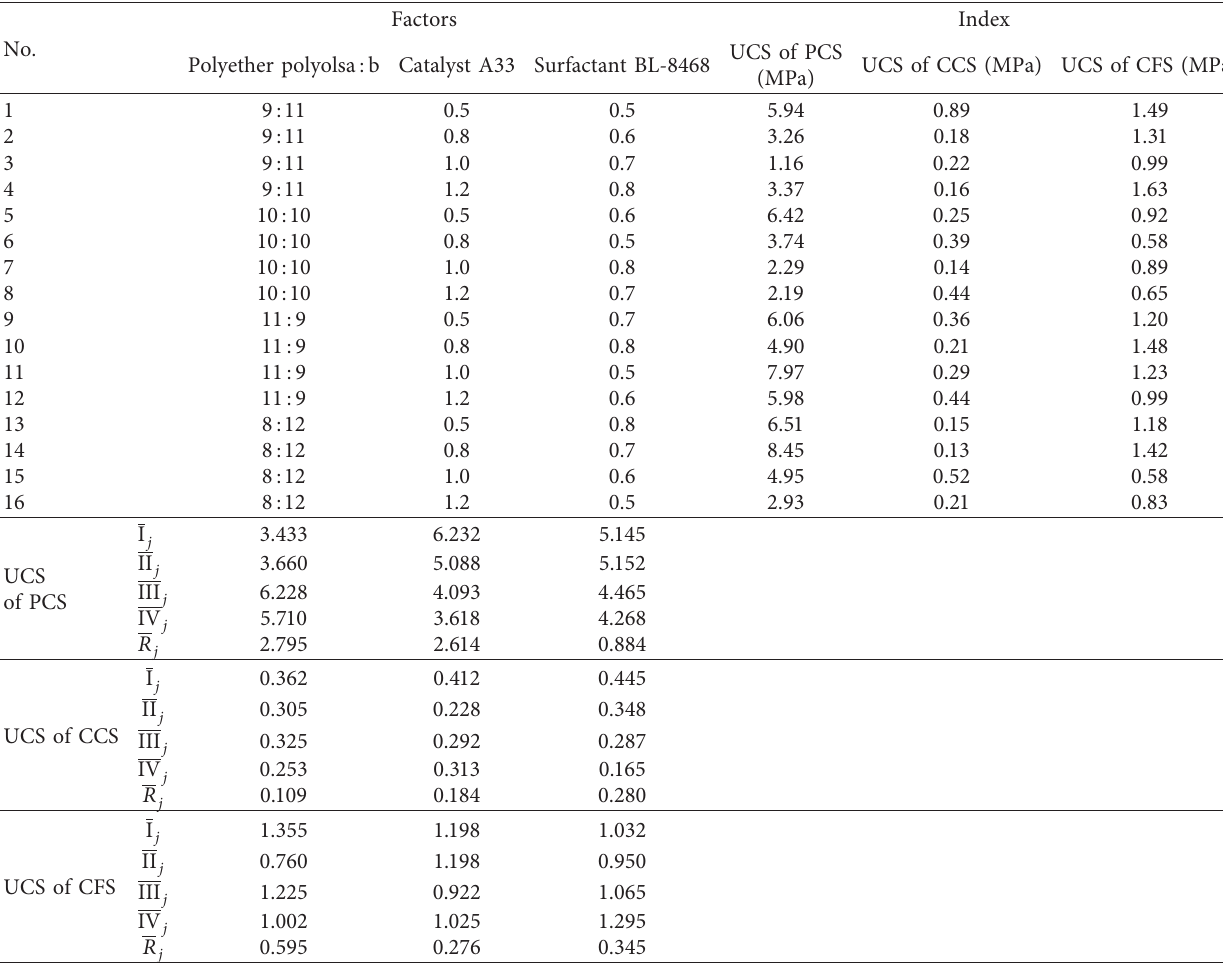
Table 7: Results of uniaxial compressive